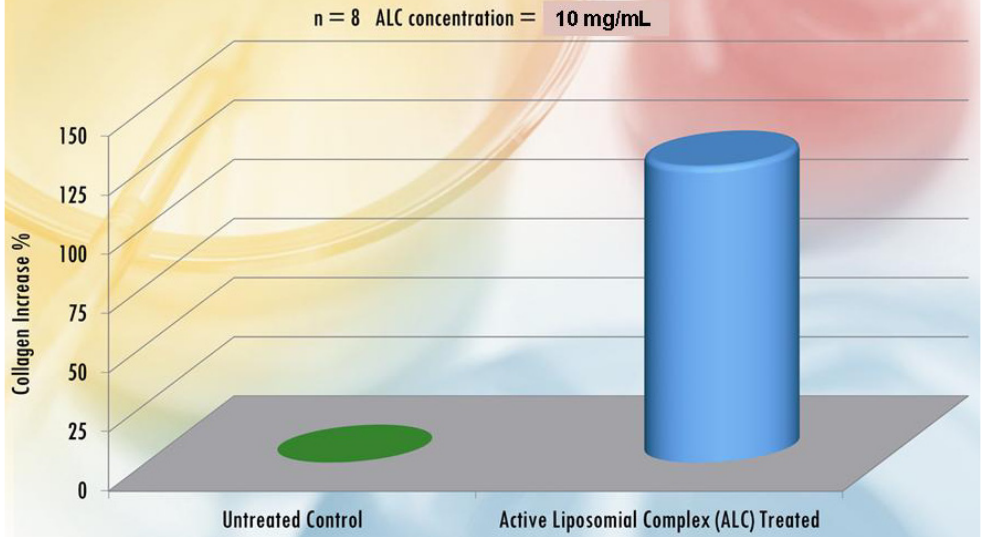
Figure 13. Percentage increase of collagen produced by fibroblast cultures added with the liposomial complex phosphatidylcholine-hyaluronic acid-chitin nanofibrils encapsulating active compounds (ALC) vs. untreated control. ALC values vs. control highly significant ( p < 0.001).